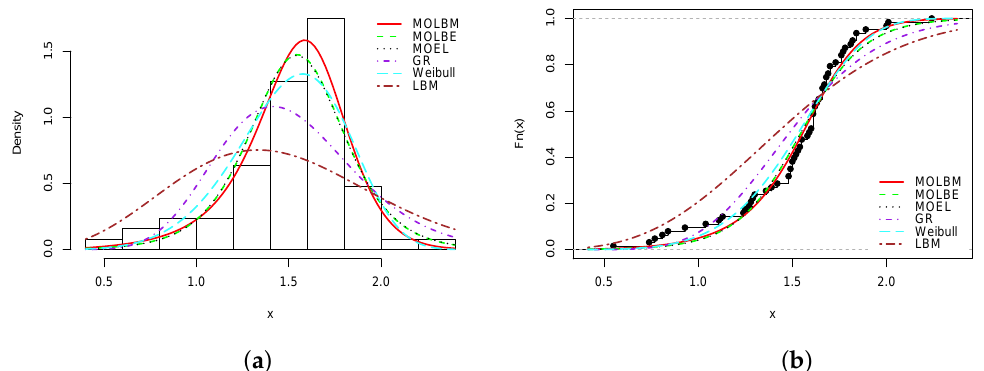
Figure 6. Plots of ( a ) estimated pdf and ( b ) estimated cdf of the MOLBM model with those of the other competitive models for Data set